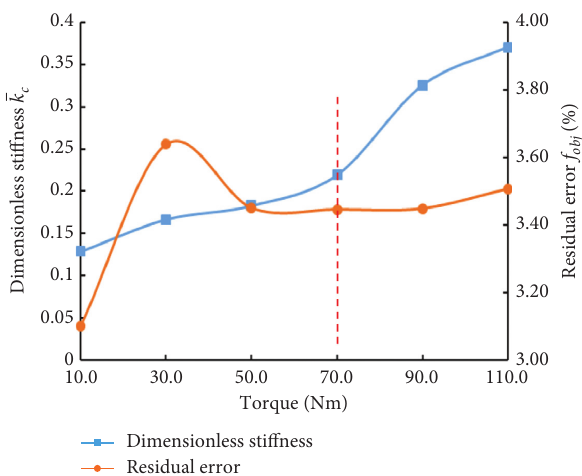
Figure 9: Optimized dimensionless stiffness and the residual error using the PSO